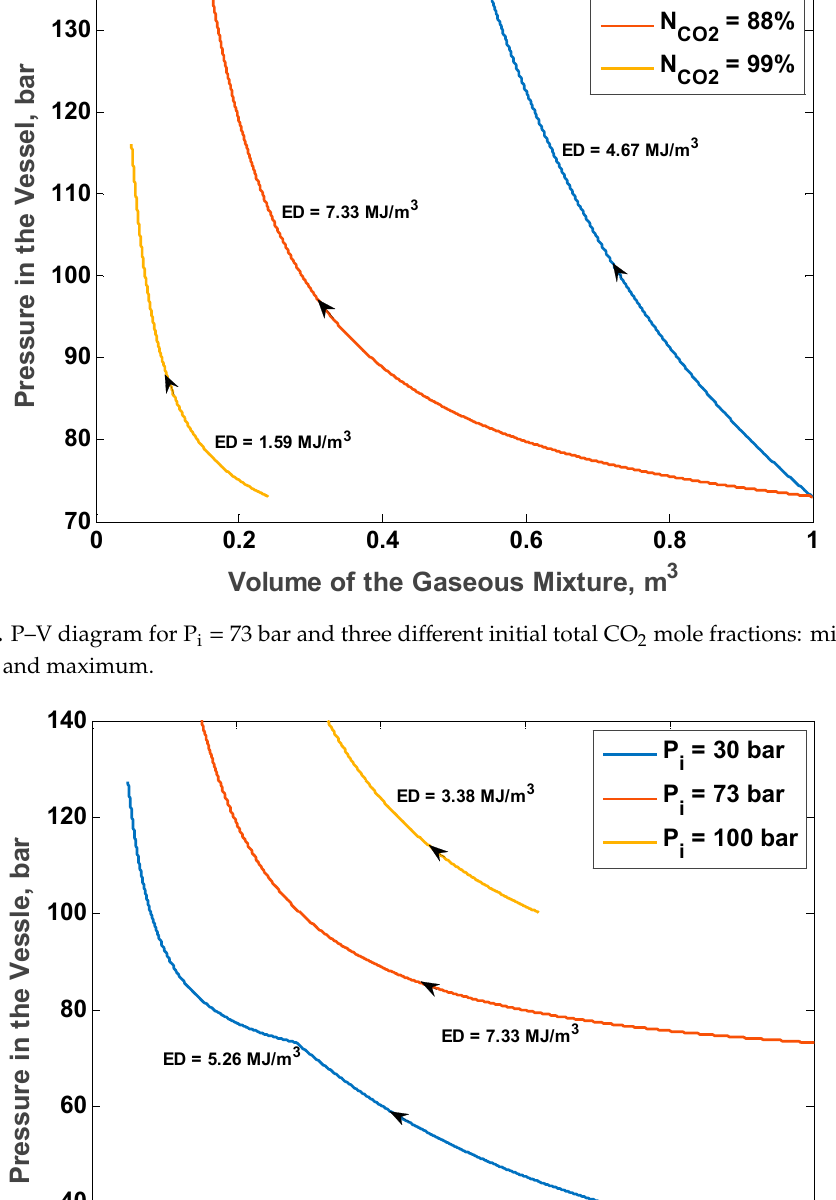
Figure 8. P–V diagram for P i = 73 bar and three different initial total CO 2 mole fractions: minimum, optimal, and maximum.